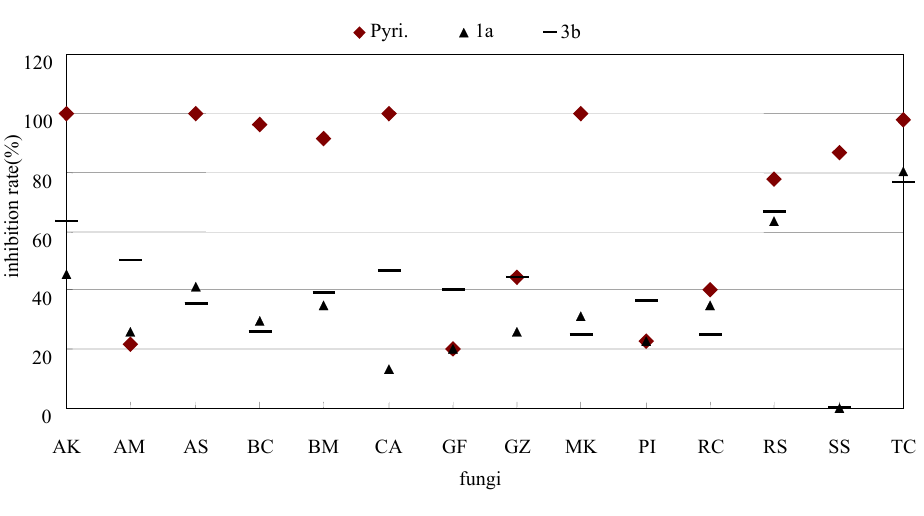
Figure 3. Parallel inhibition rate contrasts between leading compound pyrimethanil and 1a , 3b